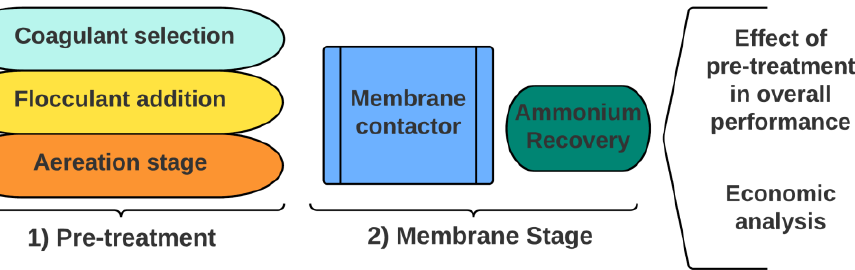
Figure 1. General scheme of the different anaerobic sidestream treatment stages used in the present study.